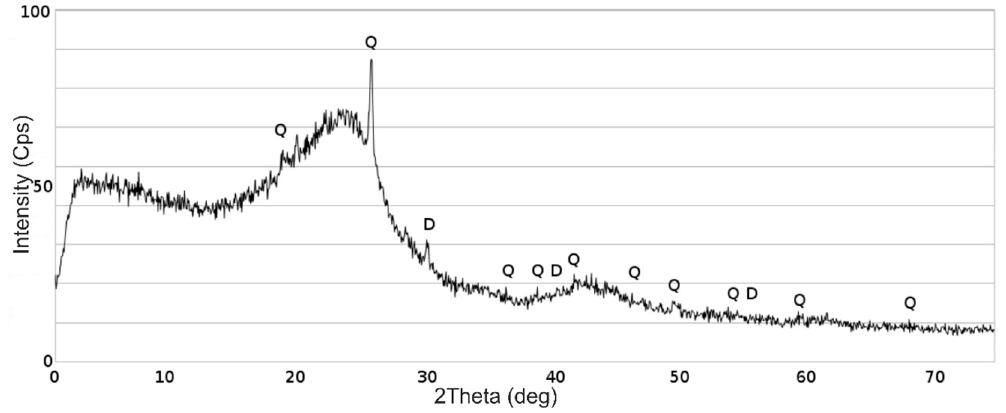
Figure 4. X-ray di ff raction pattern of gasification residue: Q—quartz, D—dolomite. Figure 4. X-ray diffraction pattern of gasification residue: Q—quartz, D—dolomite.